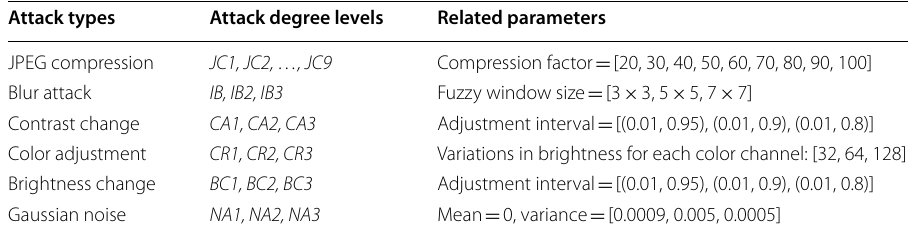
Table 4 Attack types in COMOFOD dataset